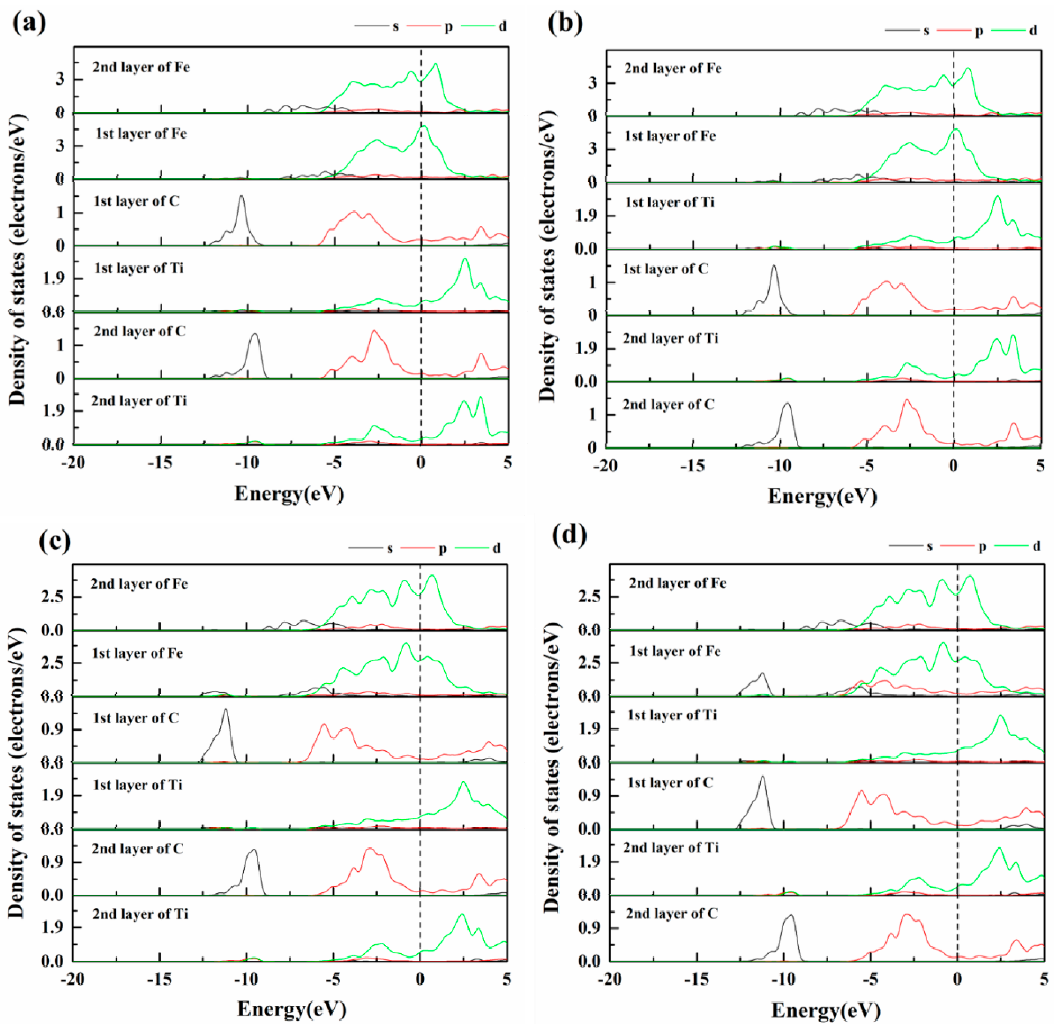
Figure 6. Partial density of states (PDOS): ( a ) Fe-on-C centre; ( b ) Fe-on-Ti centre; ( c ) Fe-bridge-C centre, and ( d ) Fe-bridge-Ti centre.